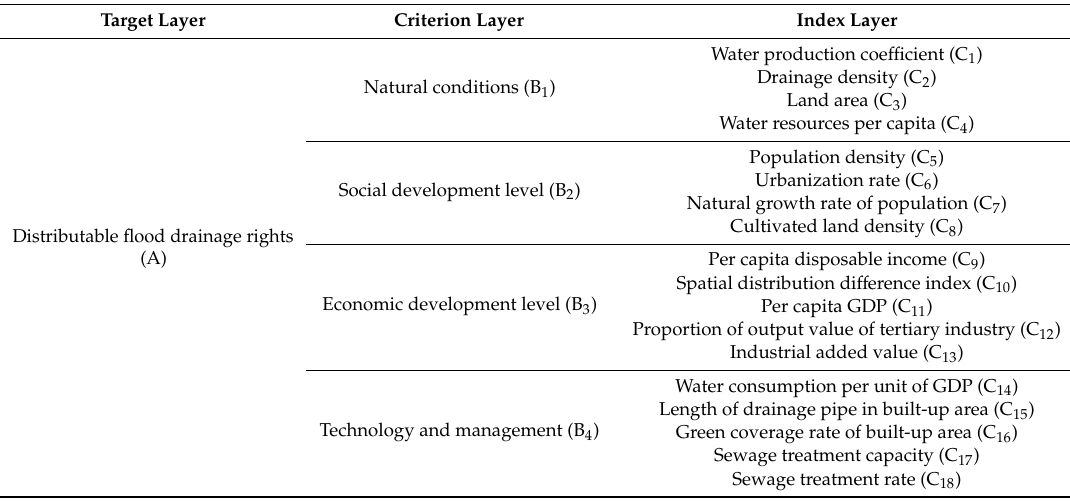
Table 1. Evaluation index system of flood drainage rights